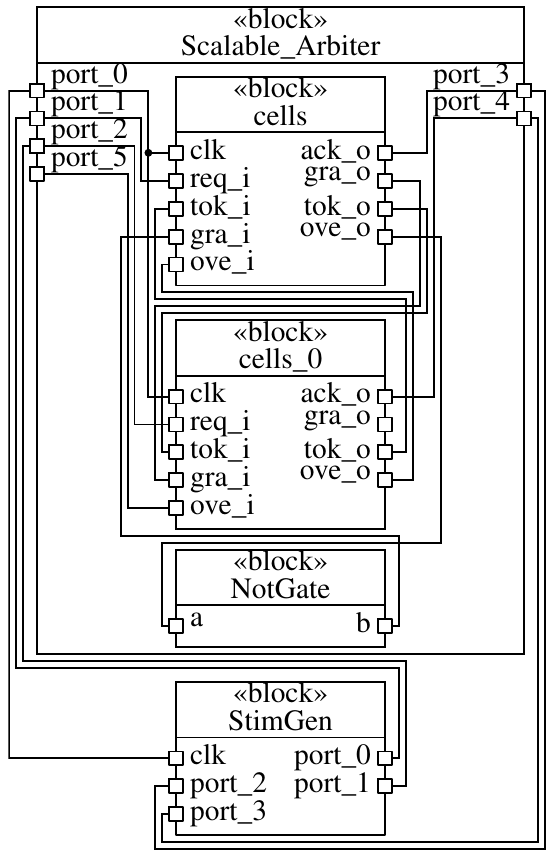
Figure 2. Diagram of the scalable arbiter shown in Figure 1 for a number of cells NUMC = 2